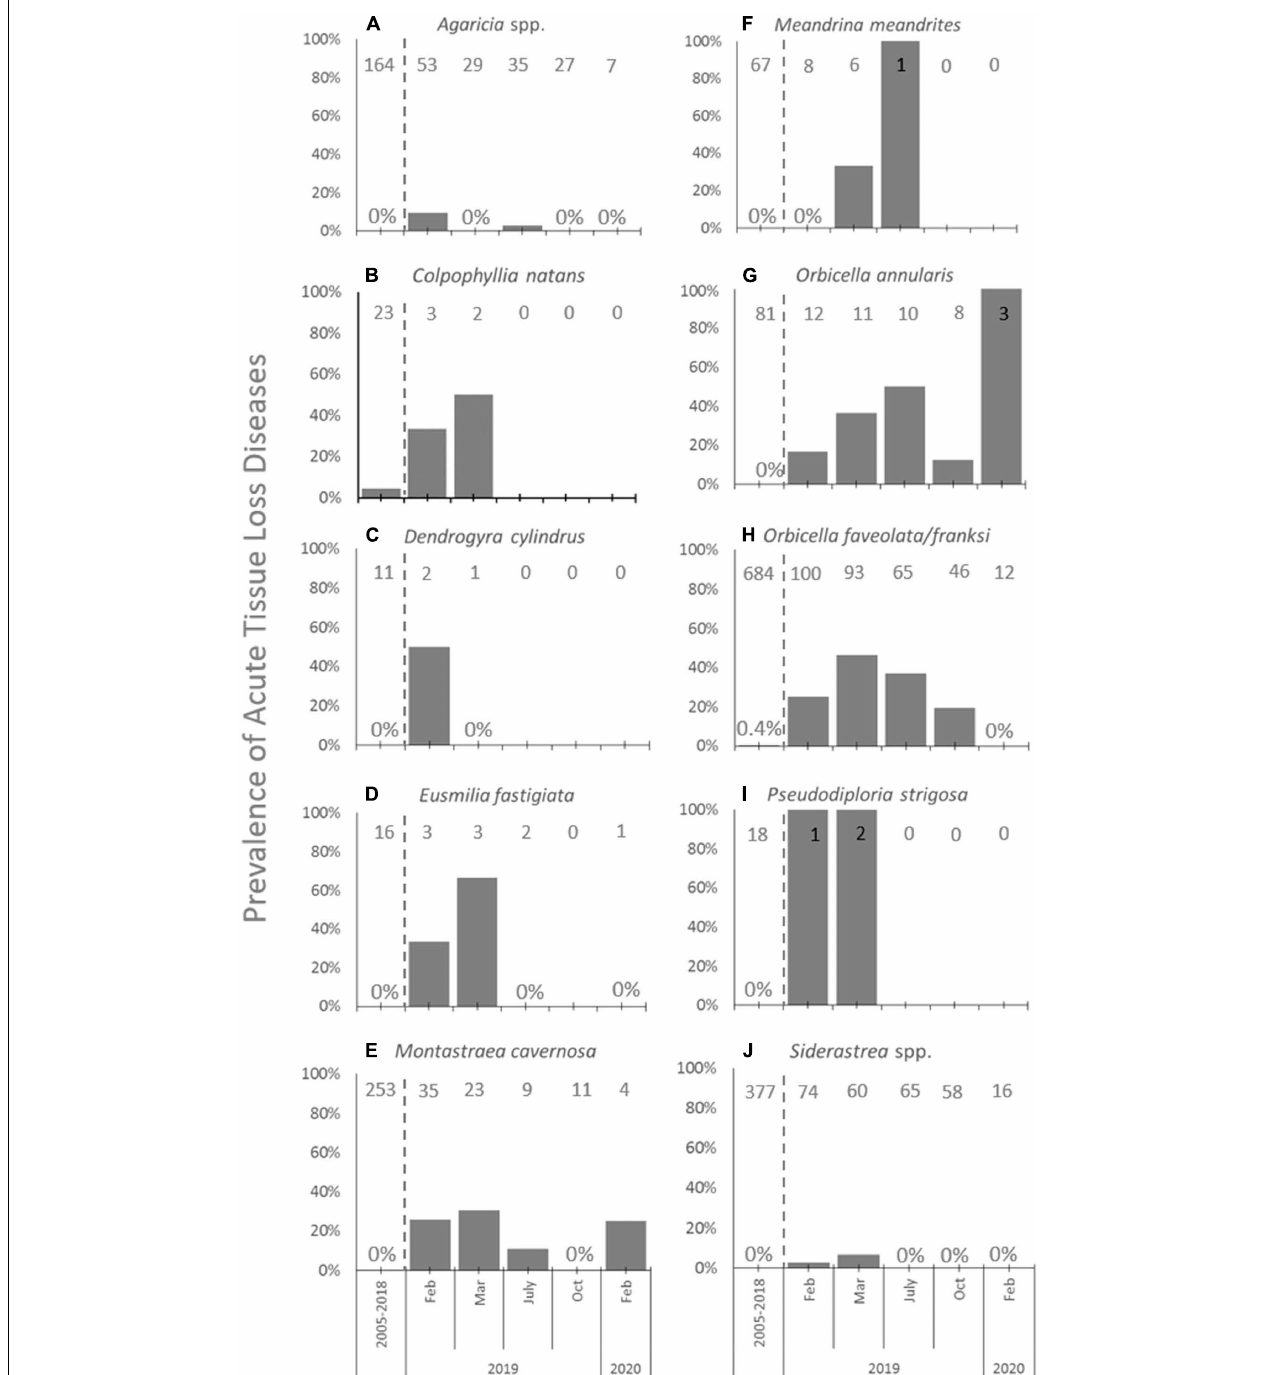
FIGURE 4 | Acute tissue loss diseases among species at FC. Prevalence (%) of acute tissue loss diseases affecting the 10 most abundant coral species (A–J) from long-term monitoring transects at FC in the time period before SCTLD was identified (combined annual monitoring between 2005 and 2018, left of dashed lines), and during repeated sampling in 2019 and in February of 2020 (right of dashed lines). Sample sizes of corals at each time point indicated at top of each graph.